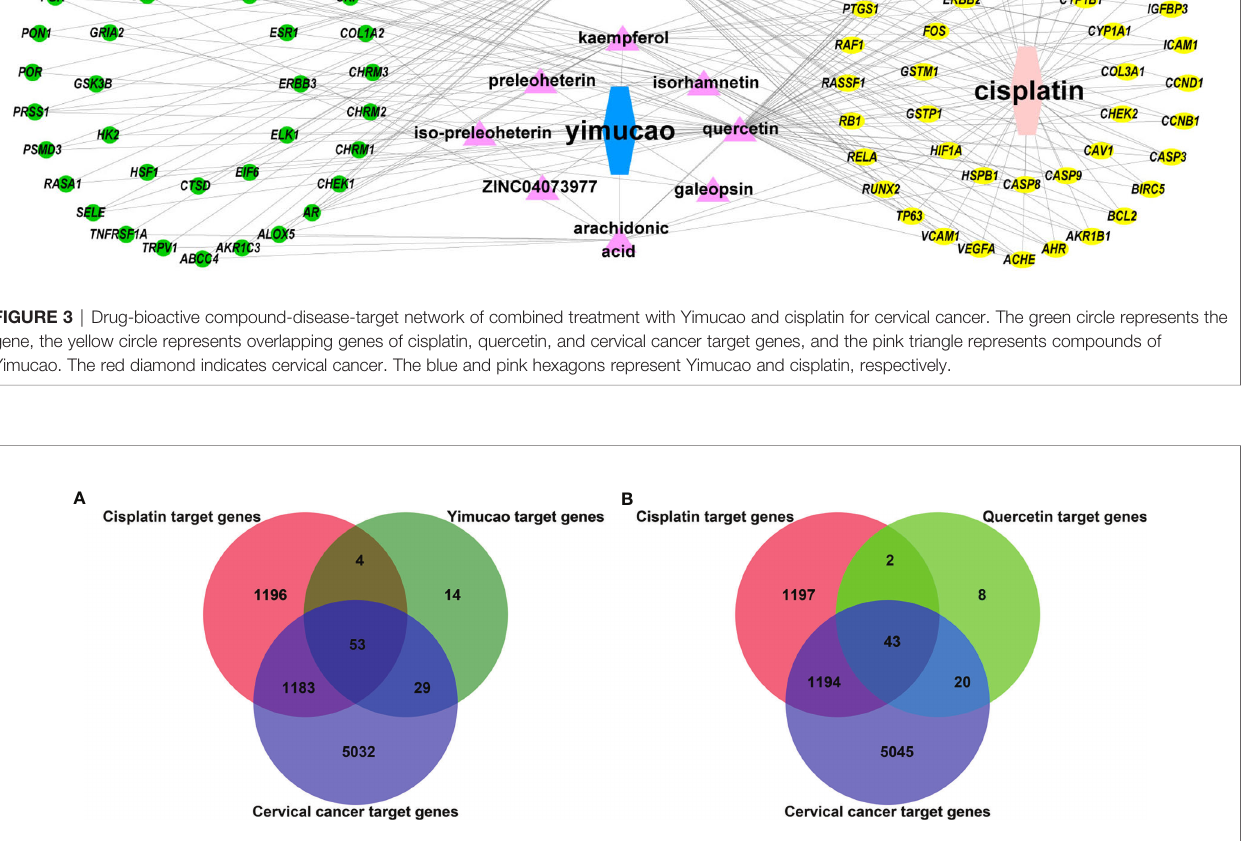
FIGURE 4 | Quercetin and cisplatin target gene prediction for cervical cancer treatment. The overlapping number of cisplatin, Yimucao (A) or quercetin (B) , and cervical cancer target genes. The red circle represents cisplatin target genes, the purple circle represents cervical cancer target genes, and the dark green and bright circles represent Yimucao and quercetin target genes,